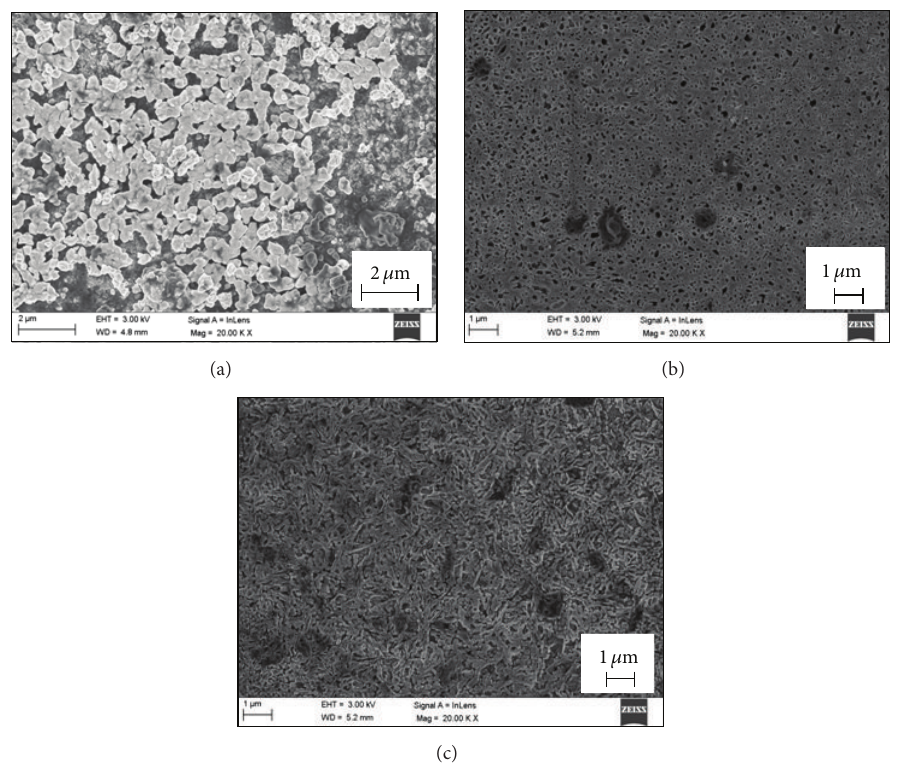
Figure 6: SEM of undoped and Cu doped ZnO thin films prepared using precursor solution of molarity of 0.1M. Here (a), (b), and (c) correspond to samples Z1, Z1C1, and Z1C2,